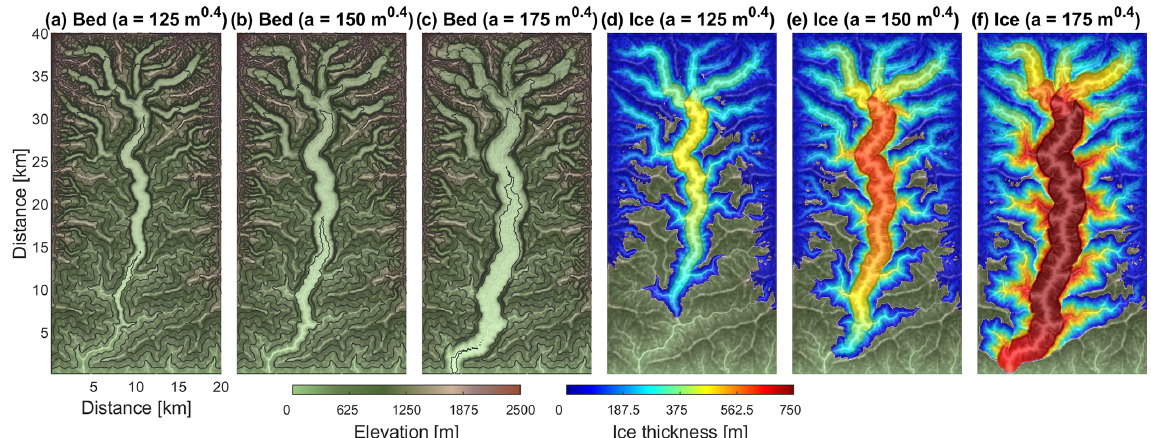
Figure B2. Differences in the evolving topography based on the width factor of the initial ice configuration of experiment (Sect. 3.2). (a– c) Evolving topographies with varying width factors ( a = 125, 150 and 175m 0 . 4 ) after 100ka. (d–f) Ice configuration after 4ka for each width factor. The same width to depth ratio of 0.25 is used in all three experiments. Spacing of contour lines in (a–c) is